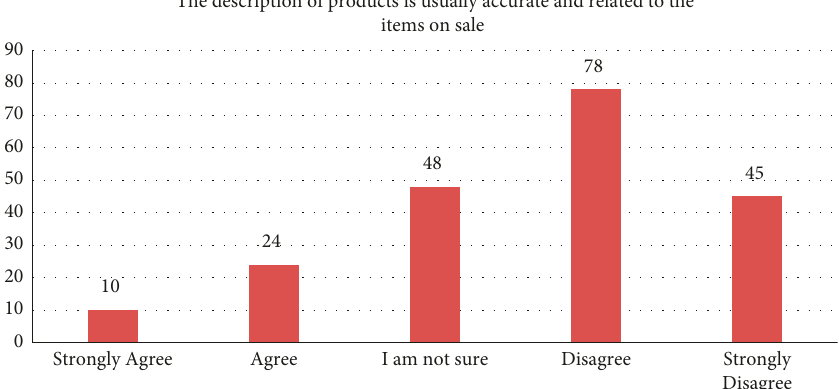
Figure 3: Participants’ responses regarding the accuracy and relevance of the promotional texts attached to items on